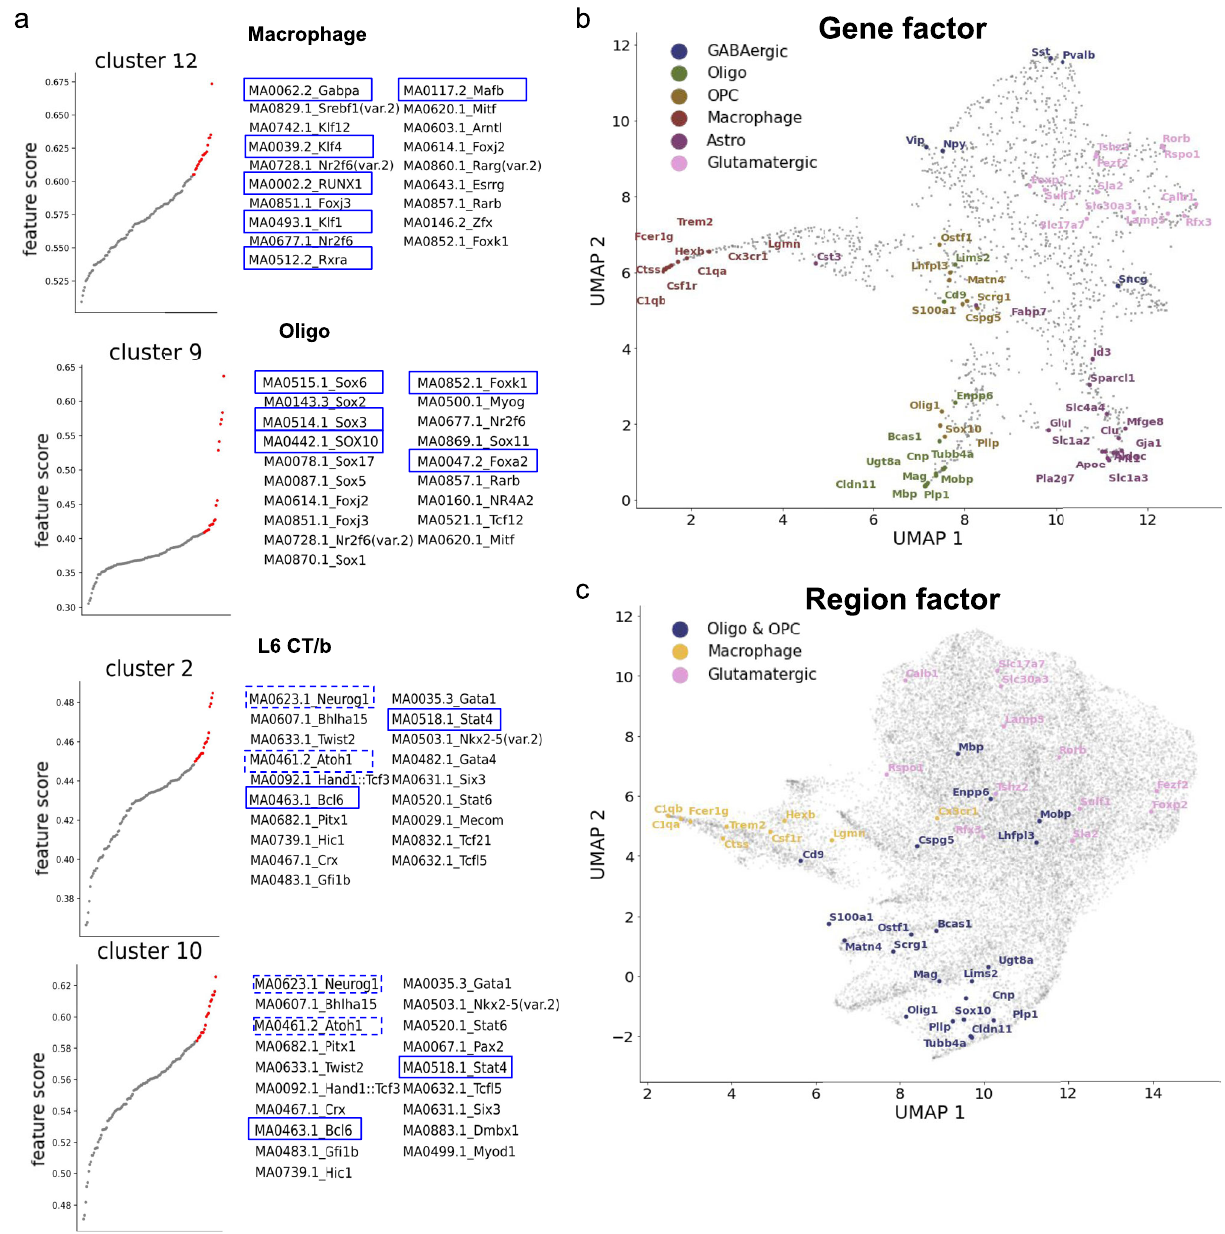
Fig. 5 | Additional results on mouse brain cortex dataset. a The top-20 scoring motifs in cluster 12 (Macrophage), 9 (Oligo), and 2 (L6 CT/b). Motifs with TFs reported for a speci fi c cell type are highlighted in blue frames. The UMAP